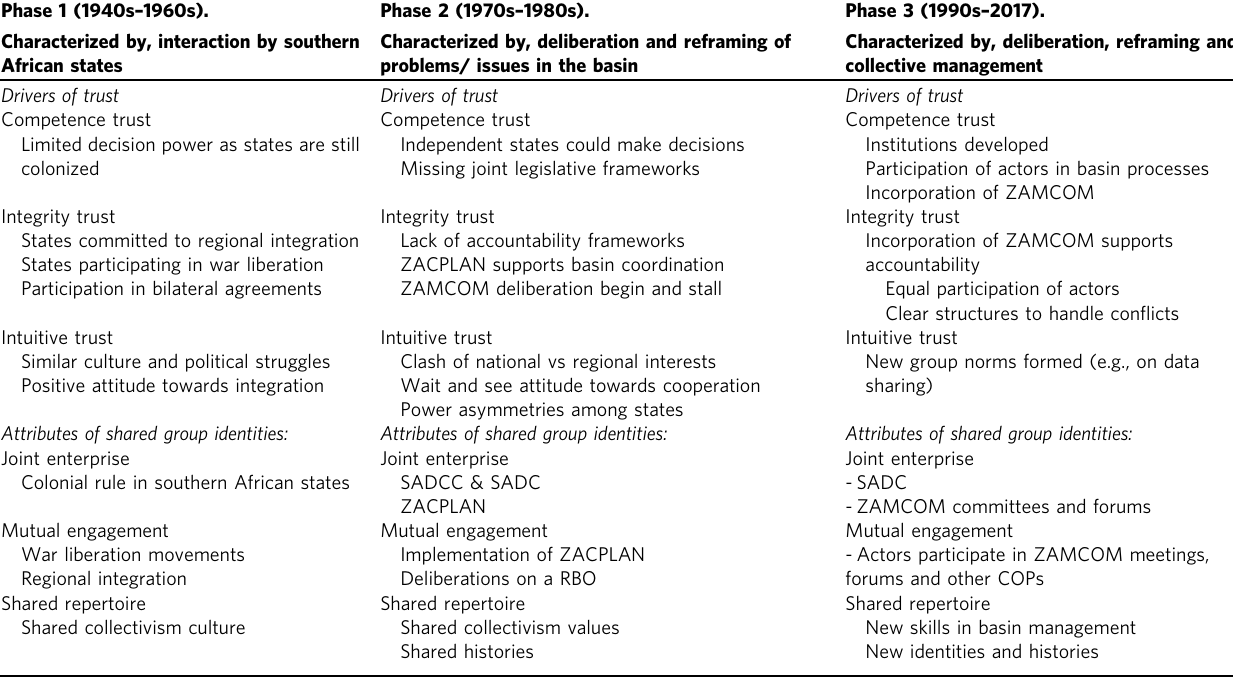
Table 2 Evolution of trust and shared identities in the Zambezi basin over time. Phase 1 (1940s –